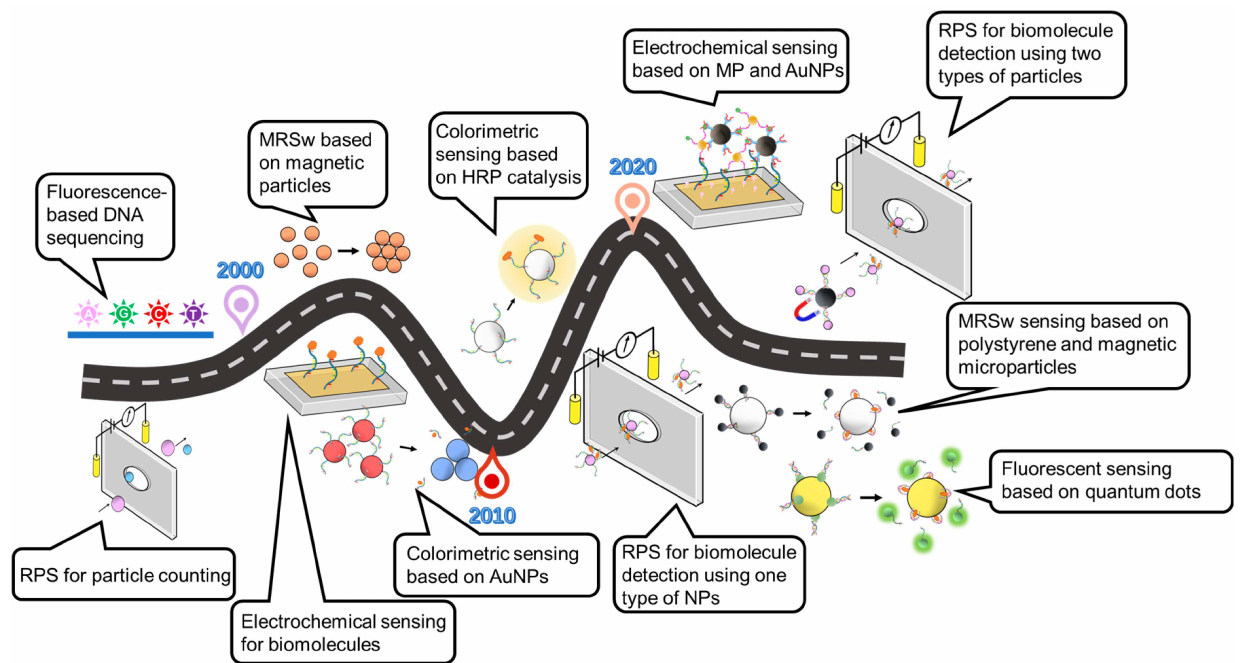
Figure 2. Roadmap/timeline of major milestones in nanoparticle–aptamer-based biomolecule